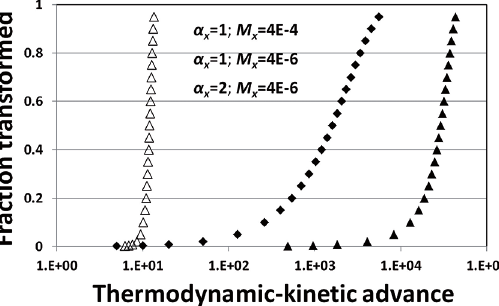
Figure 7: Martensite fraction transformed as a function of the thermodynamic-kinetic advance Ξ . Comparison of experimental (filled carats) and simulated results (triangles).